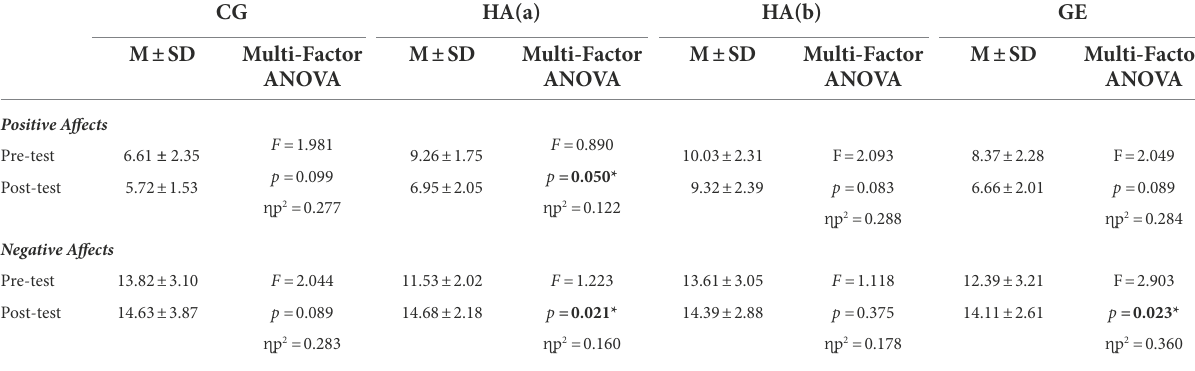
TABLE 2 Difference test results of real-time affective